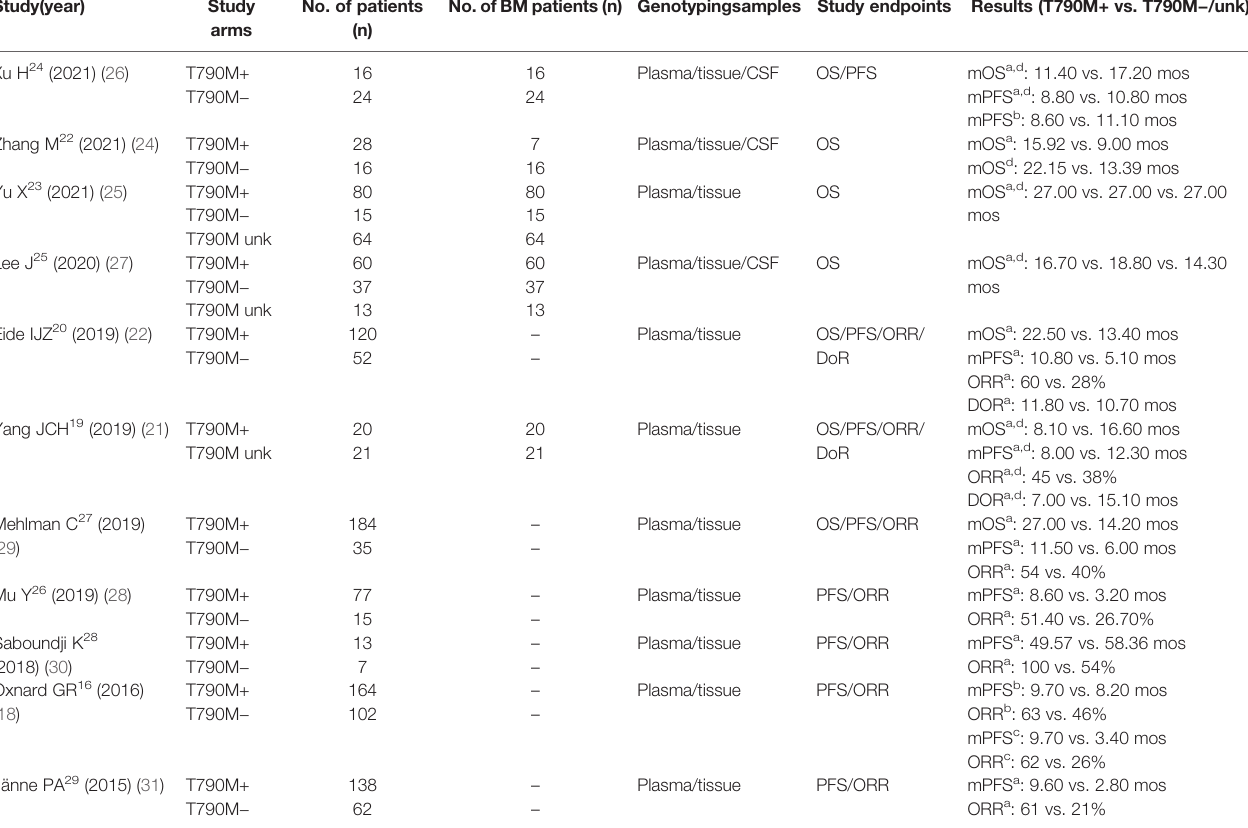
BM, brain metastases; CSF, cerebrospinal fl uid; DOR, duration of response; mos, months; ORR, objective response rate; OS, overall survival; PFS, progression-free survival; T790M+, T790M-positive; T790M − , T790M-negative; T790M unk, T790M-unknown. a Overall. b Plasma genotyping group. c Tissue genotyping group. d Brain metastases